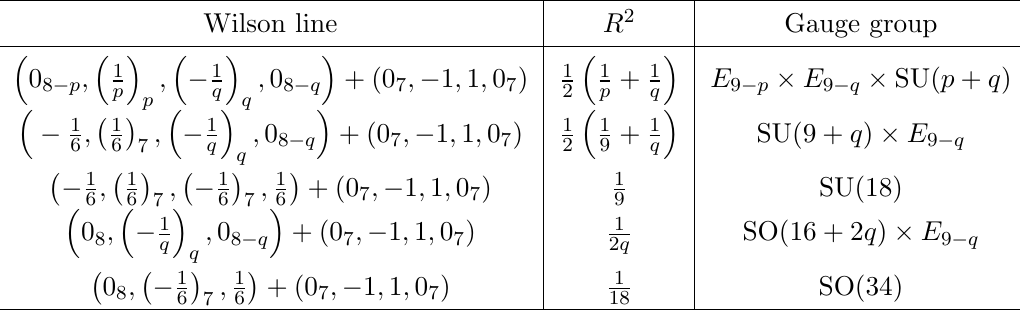
Table 2. Maximal enhancements for the E 8 (cid:2) E 8